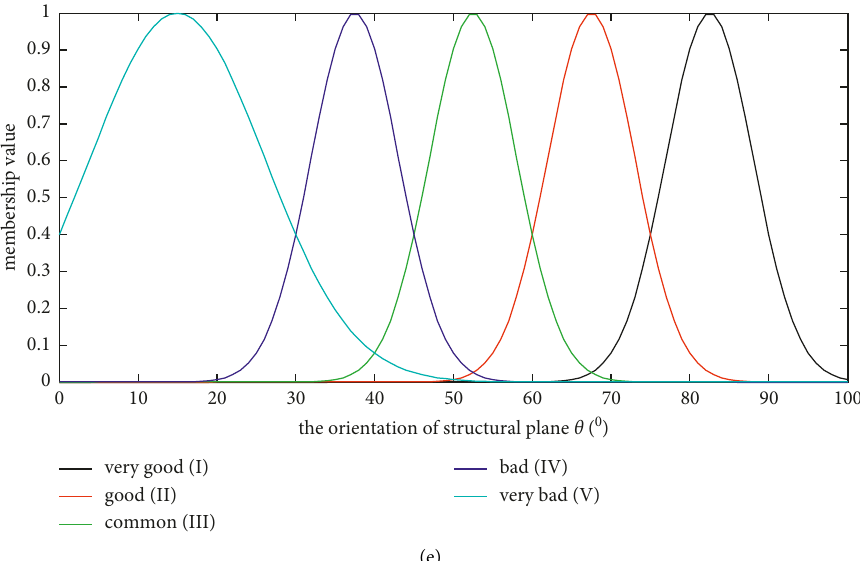
Figure 3: The membership degree function of surrounding rock quality. (a) The uniaxial compression strength of rocks at the saturation states ( R c ). (b) The rock quality index (RQD). (c) The water seepage of groundwater ( Q ). (d) The acoustic velocity of rock mass V . (e) The orientation of structural plane θ